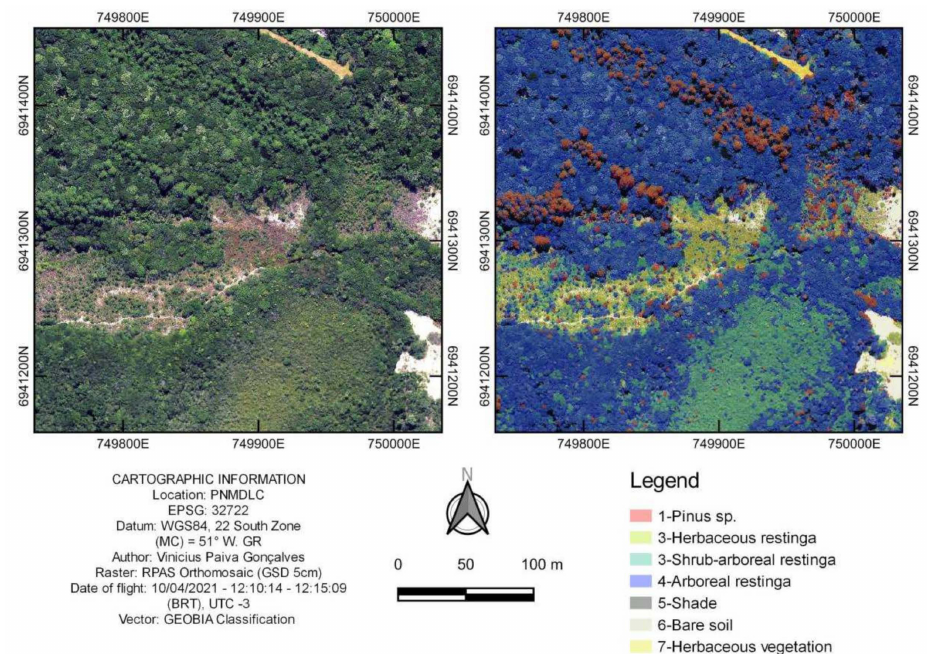
Figure 8. Comparison of the PNMDLC area orthomosaic and classified images (greater kappa), overlaid with 65% transparency. CRS: EPSG 32722. Horizontal datum WGS84, UTM projection system, 22 South Zone. MC 51 ◦ W. GR. Raster: RPAS Orthomosaic (GSD 5 cm). Flight date: 10/04/2021, 12:10:14–12:15:09 Brasilia Time (BRT),